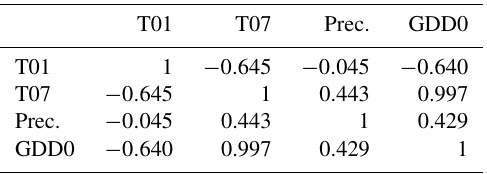
Table D1. Correlations between the four climate variables, namely the January temperature (T01), July temperature (T07), annual pre- cipitation (Prec.), and growing degree days above 0 ◦ C (GDD0), from the CHELSA data set at the locations of our plots, calculated using the R function cor().